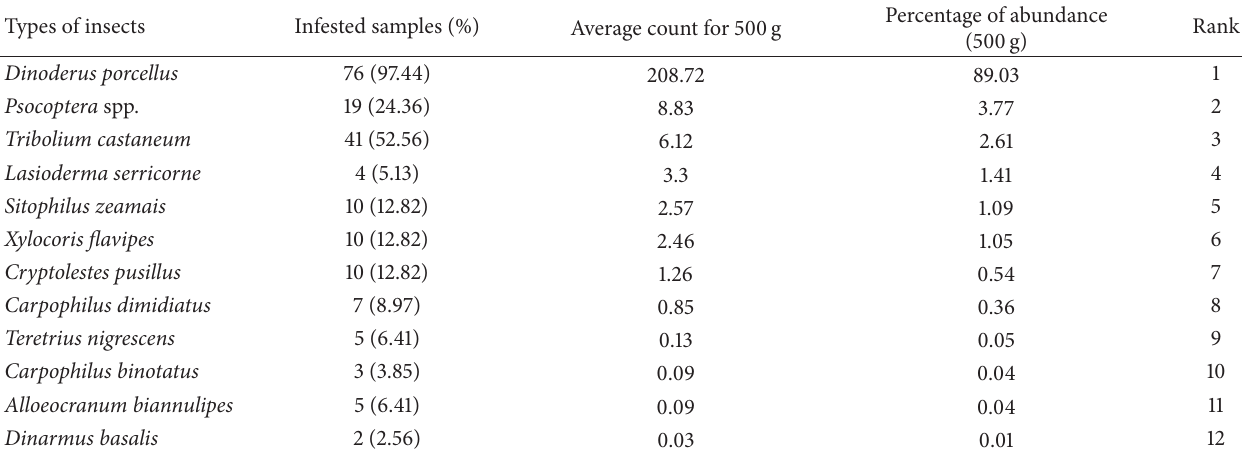
Table 4: Results of the samples incubated at the laboratory showing the species of insects used and their relative